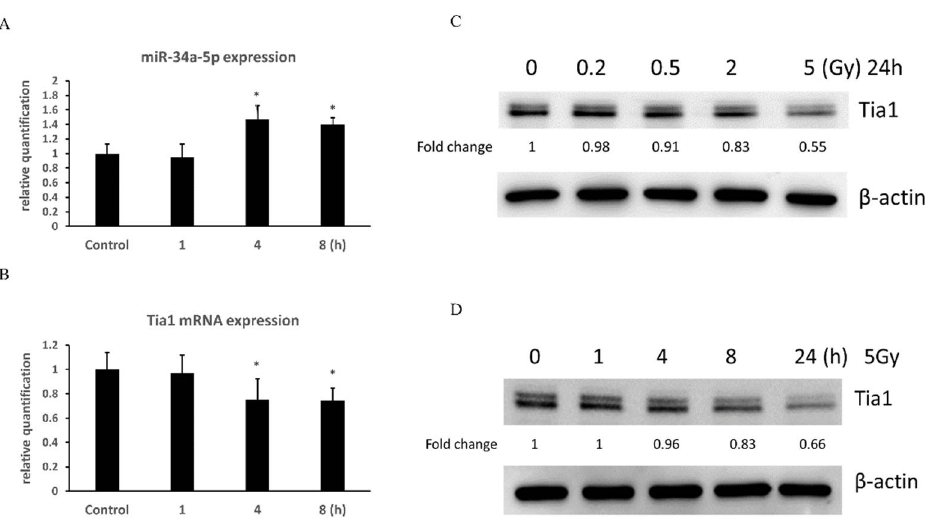
Figure 8. The expression of miR-34a-5p and Tia1 in NSCs after γ -irradiation. Time-dependent change of miR-34a-5p ( A ) and Tia1 ( B ) mRNA expression in NSCs after γ -irradiation with 5Gy. Data are expressed as mean ± SEM (n = 3). * p < 0.05 vs control. The protein expression of Tia1 in NSCs examined by western blot is dose- ( C ) and time-dependent ( D ) after γ-irradiation.